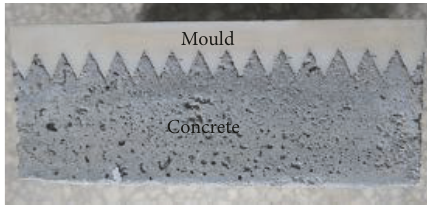
Figure 12: Roughness profiles used in simple shear